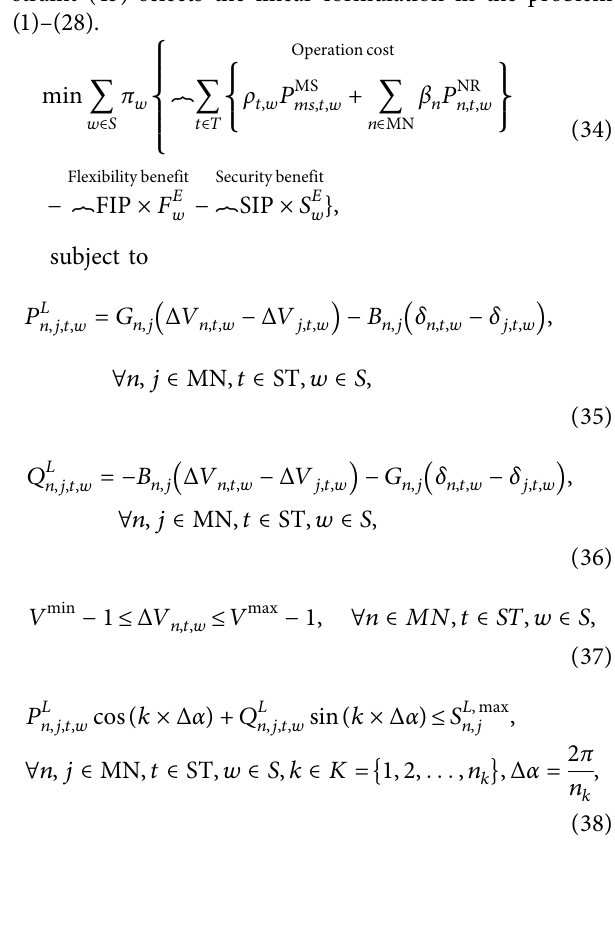
V � 1 p.u. 5 × 10 − 7 0.0020 2 × 10 − 8 (P L , Q L ) in p.u. V � 0.9 p.u.